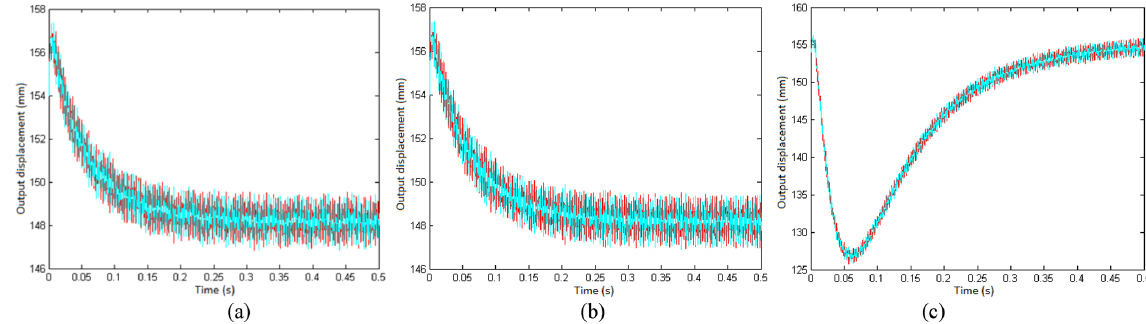
Figure 10. Influence curves of system stiffness on the synchronisation of the servo controller. Variation curves under (a) alternating load, (b) step load and (c) impact load.